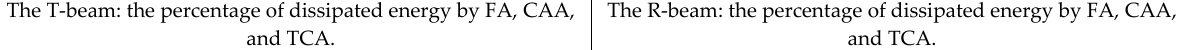
Sub-assemblages with 7 m span